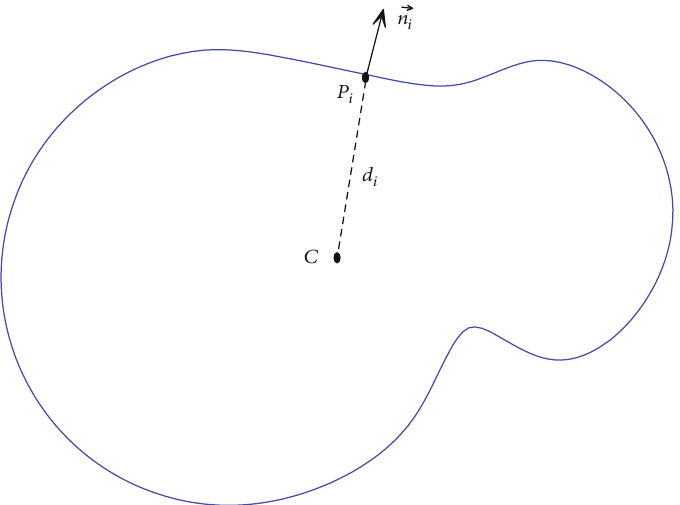
Figure 4: Deformation of the contour after